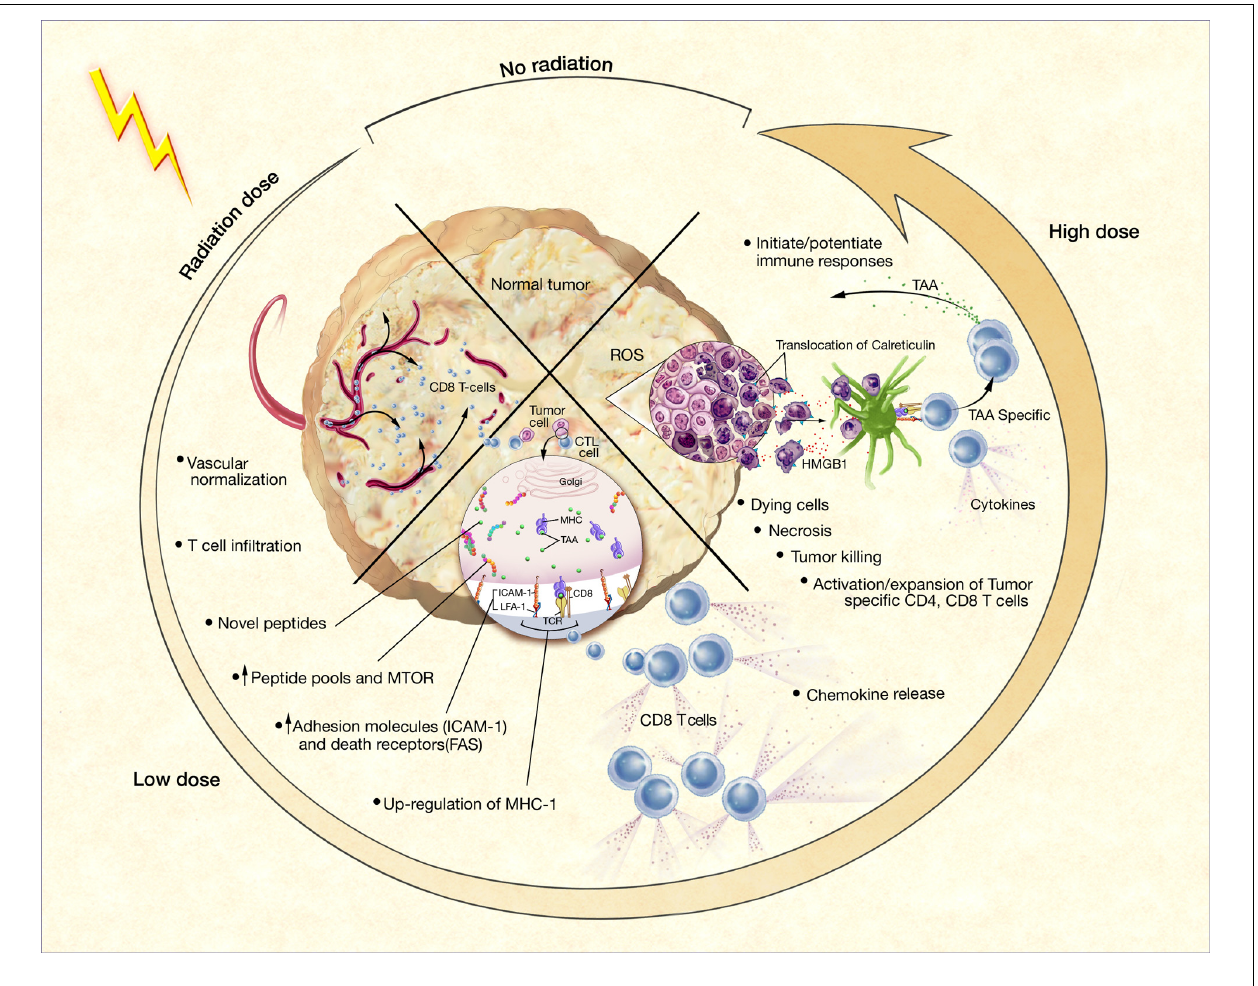
FIGURE 1 | Phenotypic and microenvironmental changes in tumors elicited by RT that can be exploited by immunotherapy (Hodge etal.,